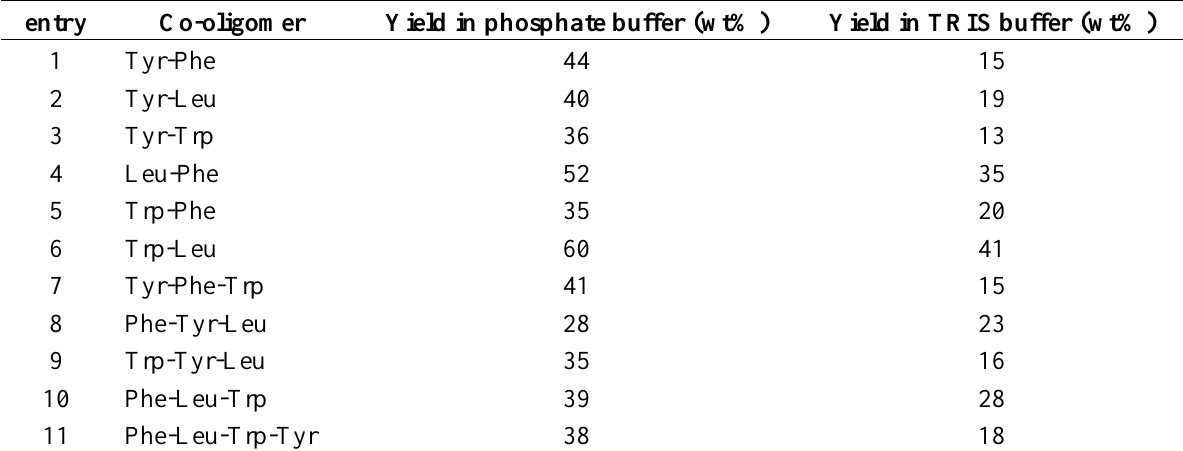
Table 2. Co-oligomer yields in phosphate and TRIS